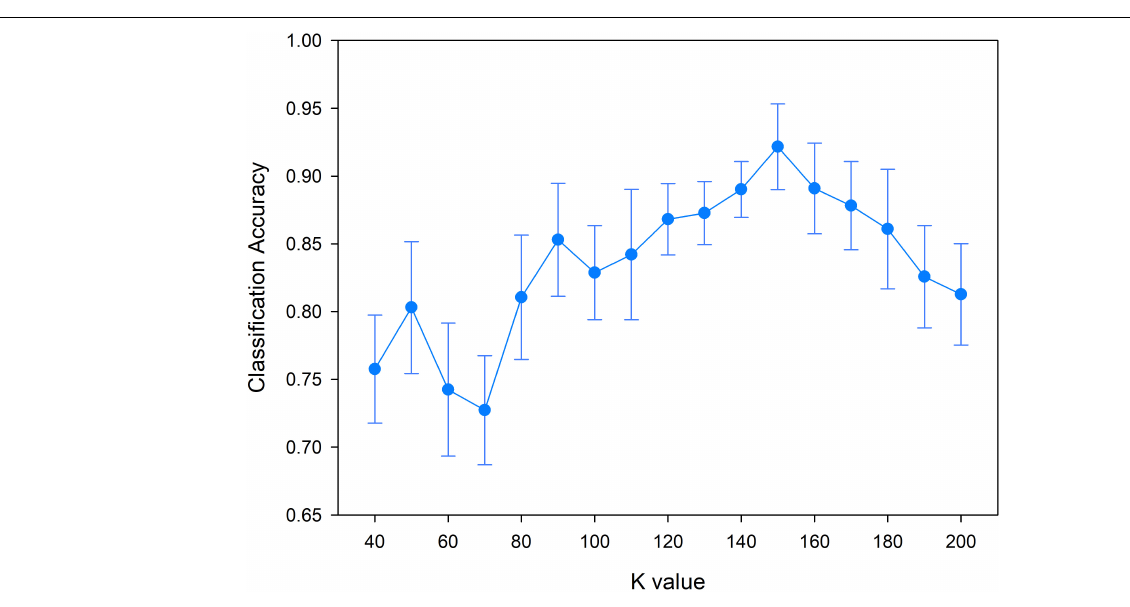
result in the HCC 3 and HCCPN values being unsolvable, so that the corresponding attribute features would be missing and could not be used to construct the classification